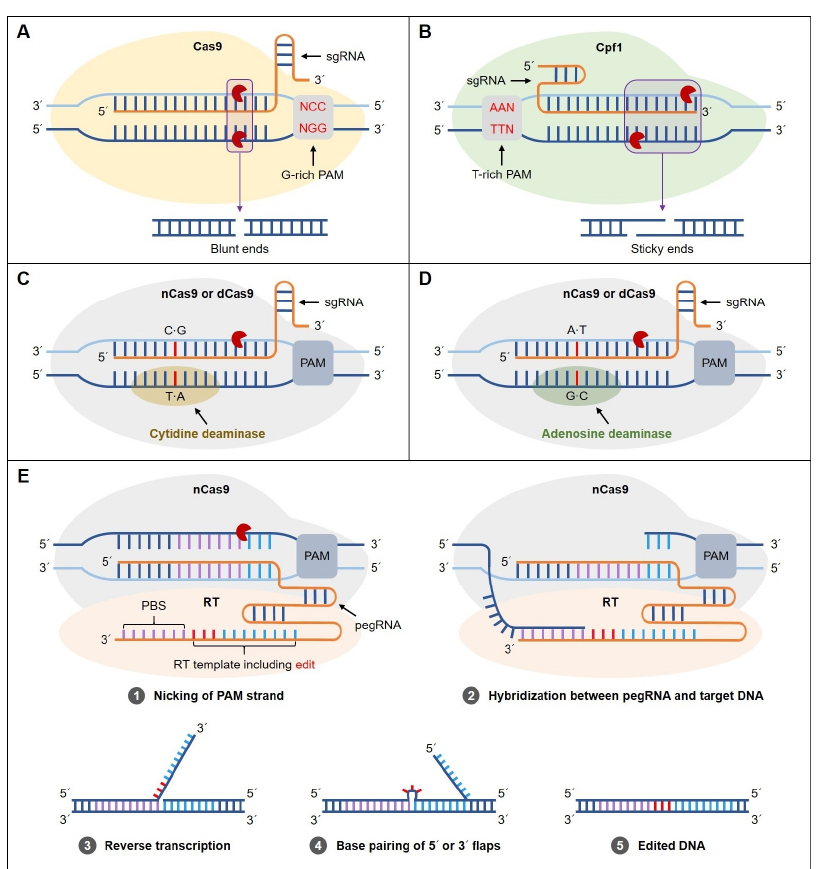
Figure 1. Clustered regularly interspaced short palindromic repeat (CRISPR) systems. ( A ) In the CRISPR–CRISPR-associated 9 (CRISPR-Cas9) system, a G-rich protospacer adjacent motif (PAM) creates double-stranded breaks (DSBs) toward the proximal end of the recognition site resulting in blunt ends. ( B ) In the CRISPR-Cpf1 system, a T-rich PAM creates DSBs at the distal region of the recognition site, producing sticky ends. ( C ) A CRISPR-Cas9-mediated cytosine base editor (CBE) system. The Cas9 nickase (nCas9) or catalytically dead Cas9 endonuclease (dCas9) fused to the Cas9–cytidine deaminase domain is guided by a single-guide RNA (sgRNA) to make single-base changes. The Cas9–cytidine deaminase makes the base change (C·G-to-T·A conversion). ( D ) A CRISPR-Cas9-mediated adenine base editor (ABE) system. The nCas9 or dCas9 fused to the Cas9–adenosine deaminase domain is guided by a sgRNA to make single-base changes. As with the CBE system, A·T-to-G·C conversion is achieved at a target site. ( E ) Prime-editing system. Gray circles with white numbers indicate the order of the editing process. 1) The prime editor consists of nCas9 fused to a reverse transcriptase (RT) and prime-editing guide RNA (pegRNA) bind to target DNA; 2) the nicked strand hybridizes the prime binding site (PBS) on the extended 3′ end of the pegRNA; 3) the RT extends the nicked DNA strand; 4) the extended strand competes for binding to the target DNA; and 5) DNA repair results in edited DNA.